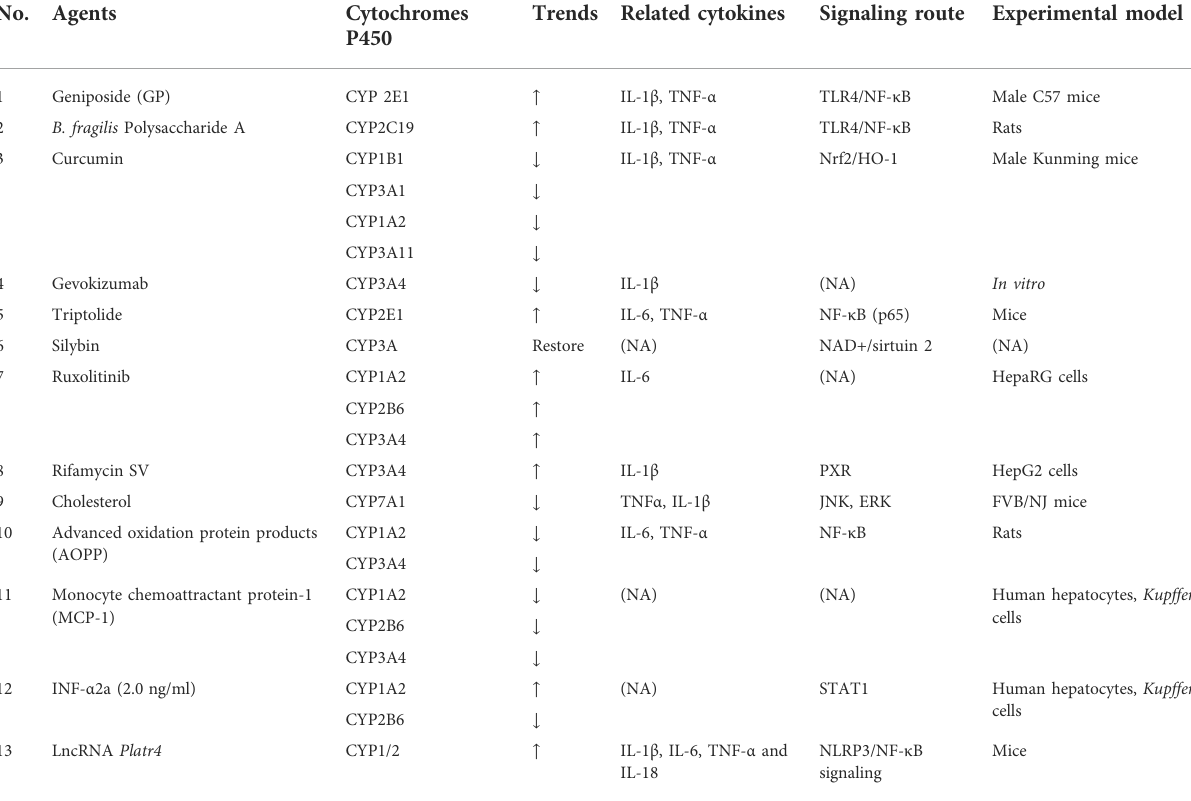
TABLE 1 Repots of drug treatment on the expression of cytochrome P450. No.